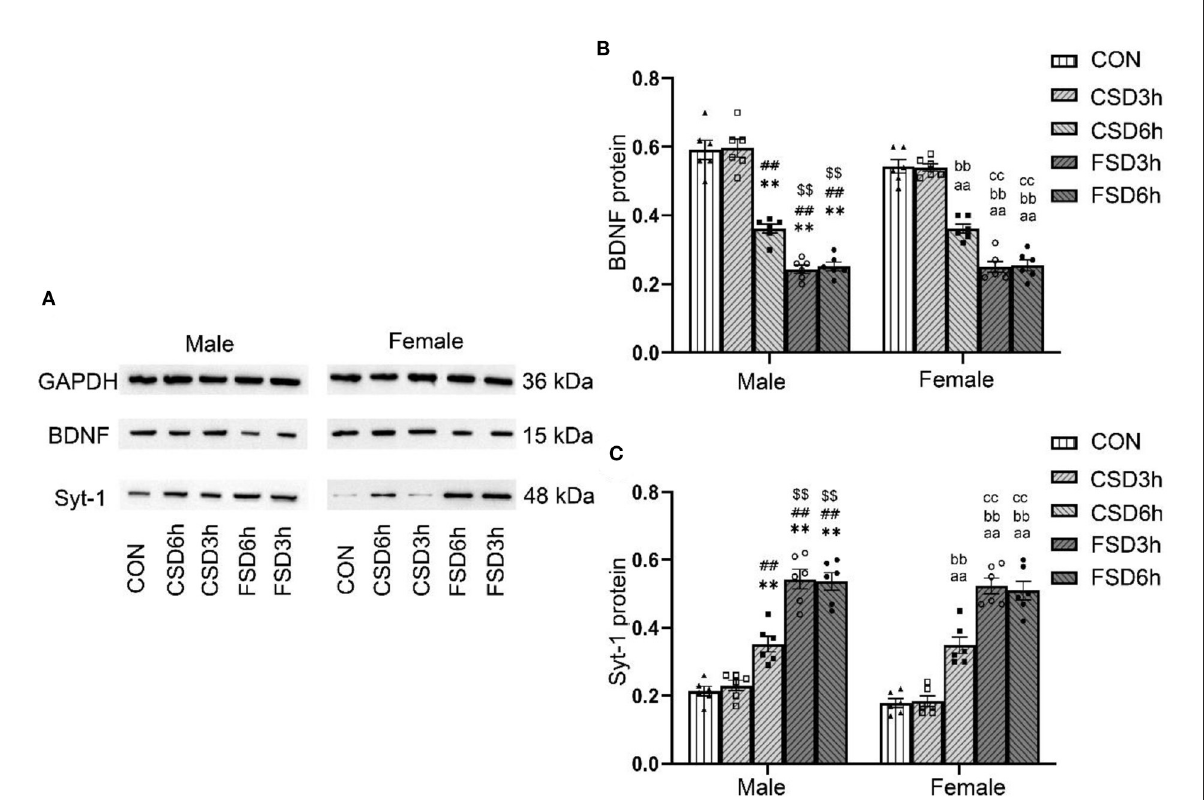
FIGURE5 Effects of MSD on the expression of hippocampal of BDNF and Syt-1 proteins in the offspring. (A) The expression levels of BDNF ( n = 12, 6 females and 6 males in each treatment group) and Syt-1 ( n = 12, 6 females and 6 males in each treatment group) proteins in the hippocampus at 2 months. The results of protein quantification are depicted in (B,C) . ** P < 0.01 vs. Male CON group; ## P < 0.01 vs. Male CSD3h group; $$ P < 0.01 vs. Male CSD6h group; aa P < 0.01 vs. Female CON group; bb P < 0.01 vs. Female CSD3h group; cc P < 0.01 vs. Female CSD6h group.